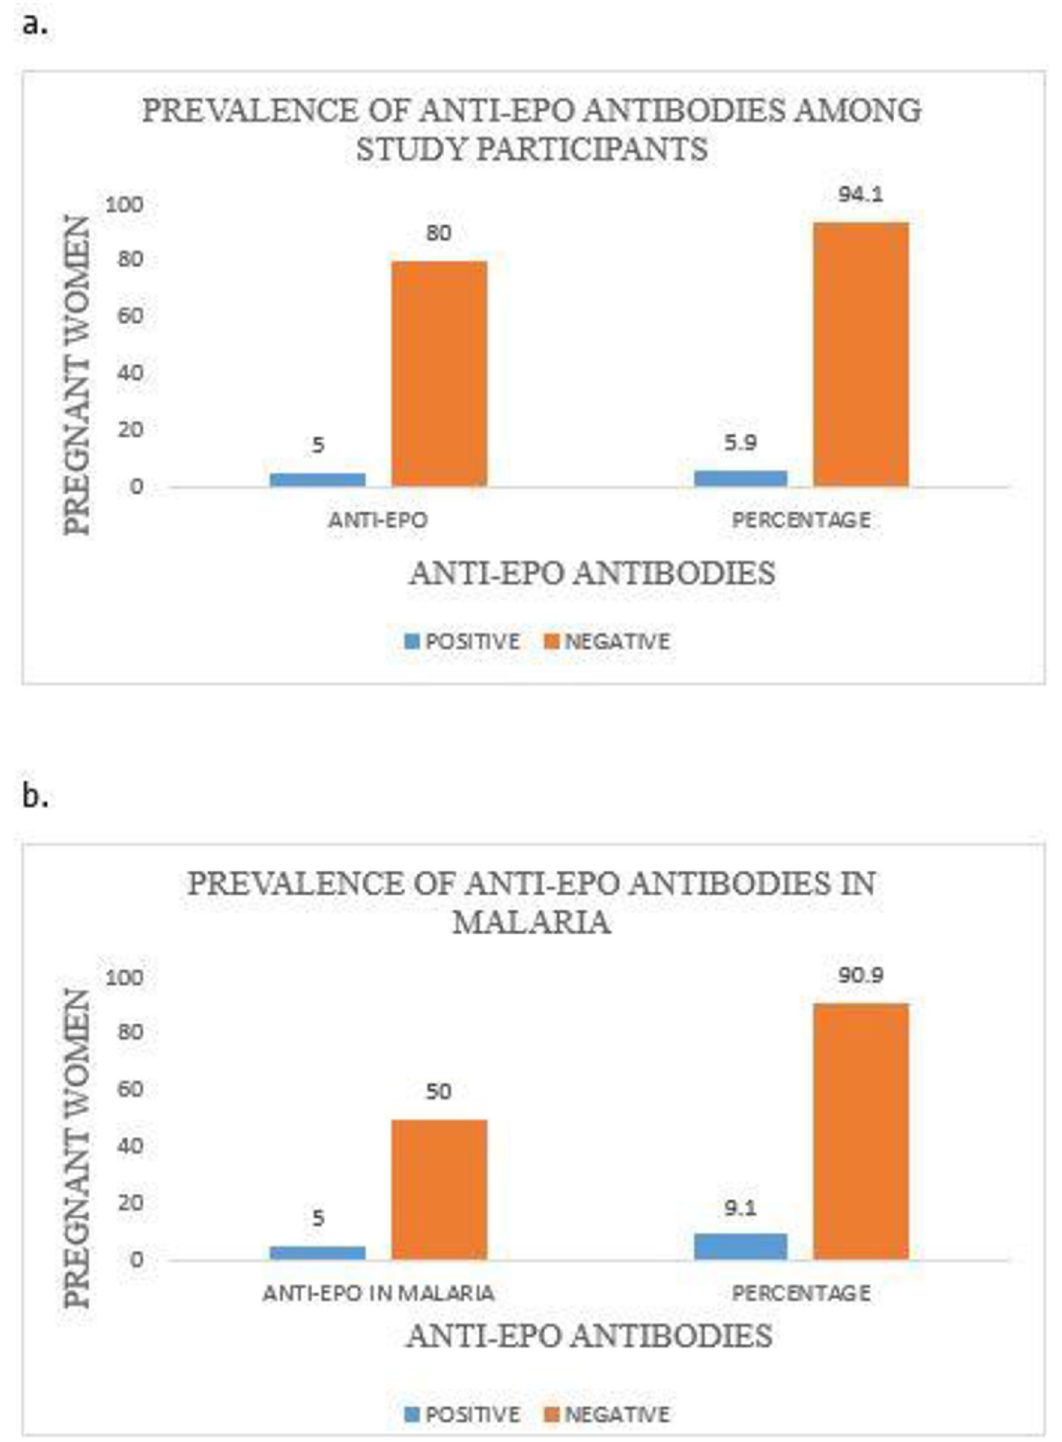
Fig 3. Prevalence of serum anti-EPO antibodies among (a) the Study participants and (b) P . falciparum- infected pregnant women. EPO = Erythropoietin.